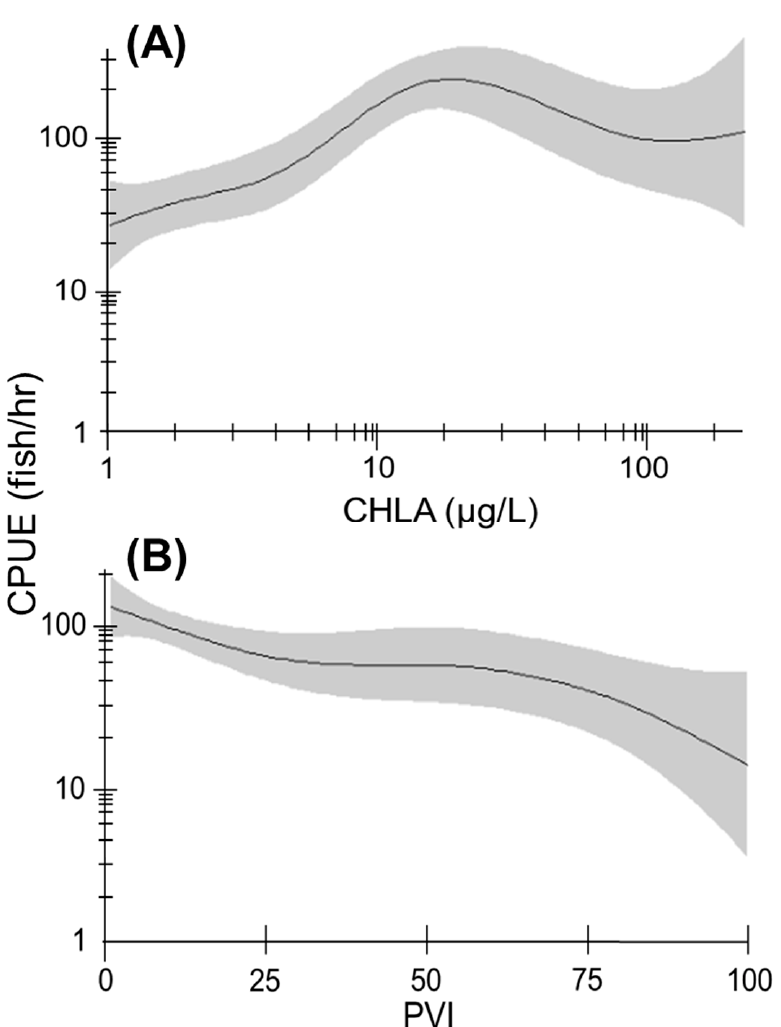
Figure 3. Generalized additive model relating Bluegill catch per unit effort (CPUE, fish/hr by electrofishing) to ( A ) chlorophyll- a concentration (CHLA, µ g/L, p < 0.001) and ( B ) percent of lake volume inhabited with macrophytes (PVI, p = 0.001) in Florida lakes. Shaded areas are 95% confidence intervals.